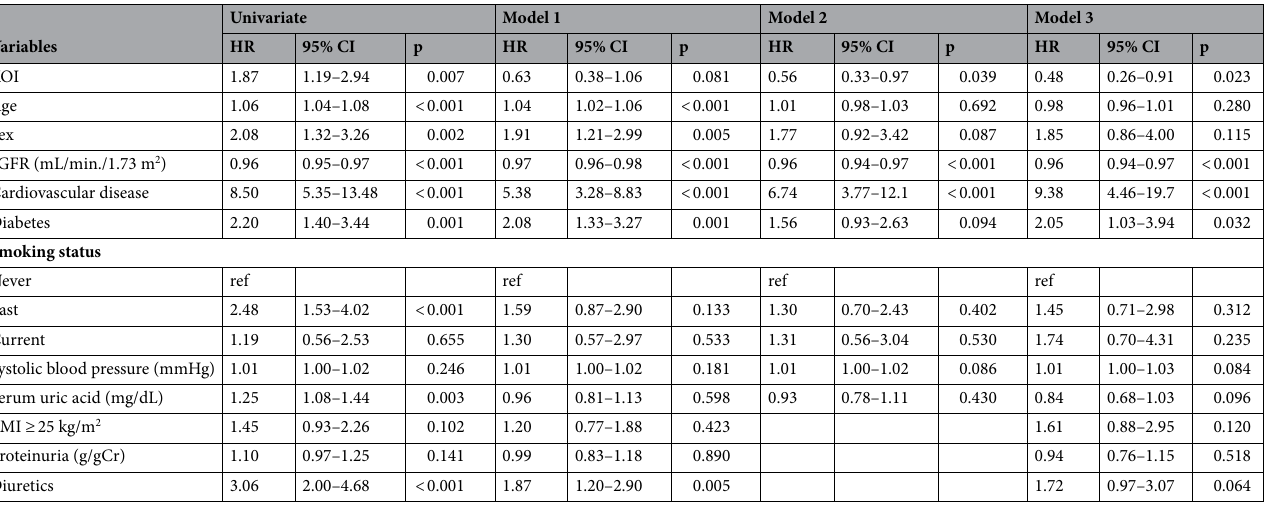
Table 3. Cox regression analyses of independent factors for cardiovascular events. Model 1; adjusted for age, sex, and eGFR. Model 2; adjusted for age, sex, eGFR, history of cardiovascular disease, diabetes, smoking status, systolic blood pressure, and serum uric acid. Model 3; adjusted for age, sex, eGFR, history of cardiovascular disease, diabetes, smoking status, systolic blood pressure, serum uric acid, BMI ≥ 25 kg/m 2 , proteinuria (g/gCr), and use of diuretics. XOI xanthine oxidase inhibitor, eGFR estimated glomerular filtration rate, BMI body mass index, HR hazard ratio, CI confidence